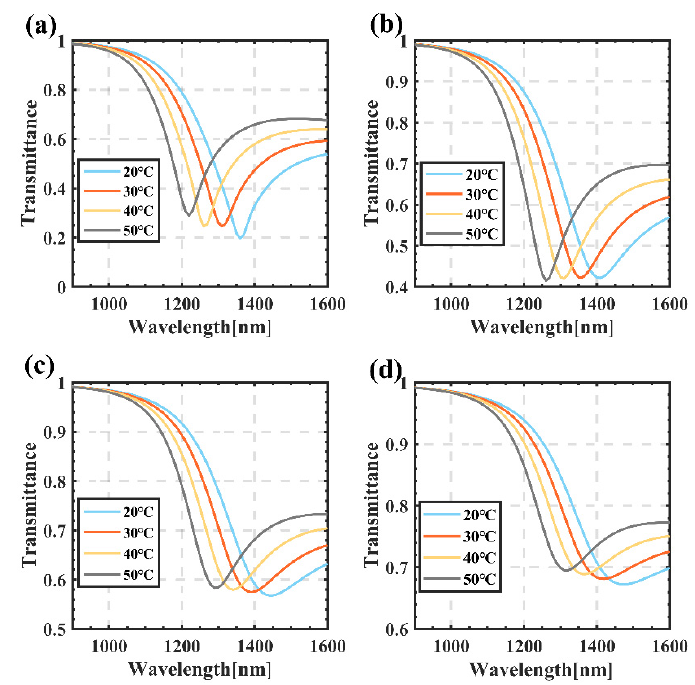
Figure 6. Influence of d_Ag and d_Au on the transmittance spectra: ( a ) d_Ag = 30 nm, d_Au = 10 nm; ( b ) d_Ag = 30 nm, d_Au = 15 nm; ( c ) d_Ag = 30 nm, d_Au = 20 nm; ( d ) d_Ag = 30 nm, d_Au = 25 nm. Table 2. Comparison table of performance